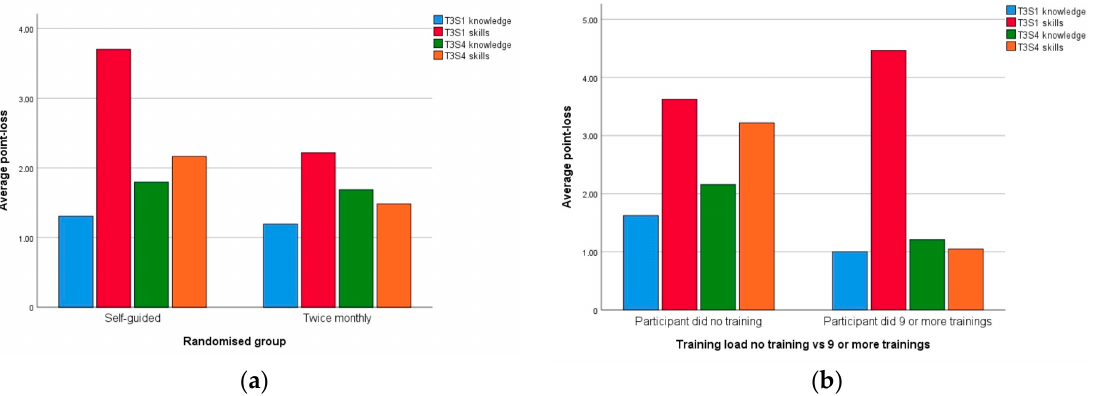
Figure 6. Bar charts of knowledge and skills points lost at test 3 scenarios 1 and 4 ( a ) according to group randomised to and ( b ) according to training-load group. T = test, S =